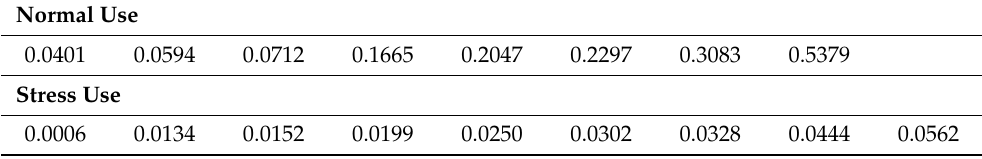
Table 4. Failure times of transformer